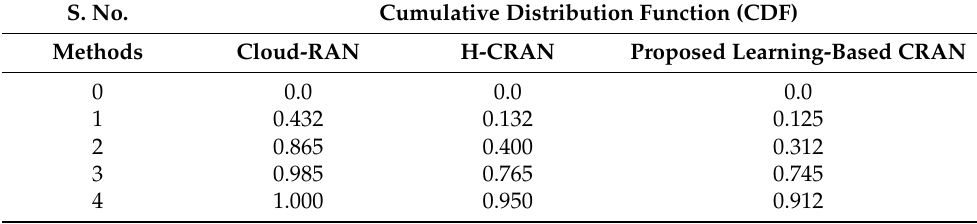
Table 4. CDF ‐ based data rate by accessing resource allocation.